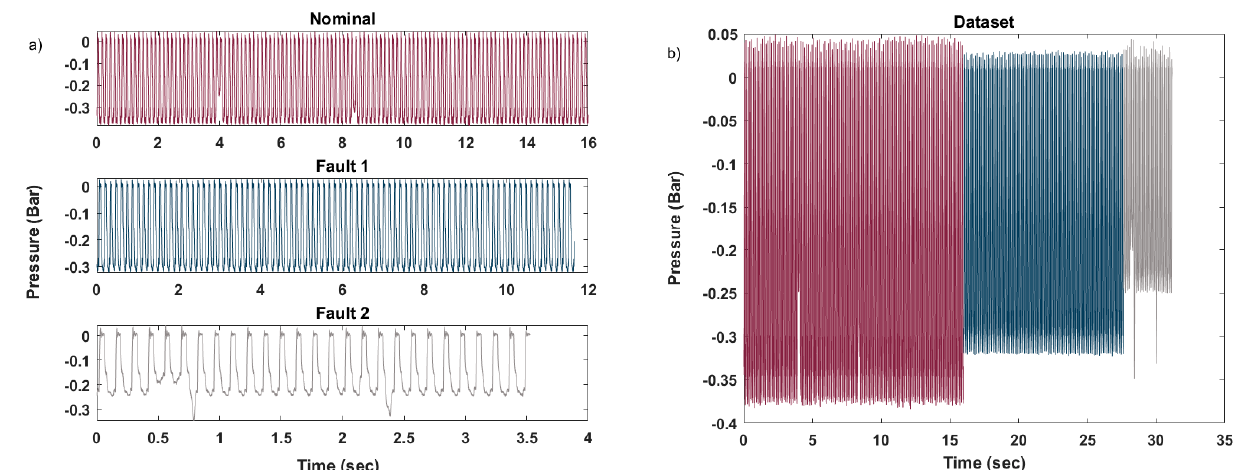
Figure 3. Pressure signals produced by the suction cups during the nominal condition and the two fault conditions, ( a ) considered separately, and ( b ) put in sequence to simulate the detachment of the first and second suction